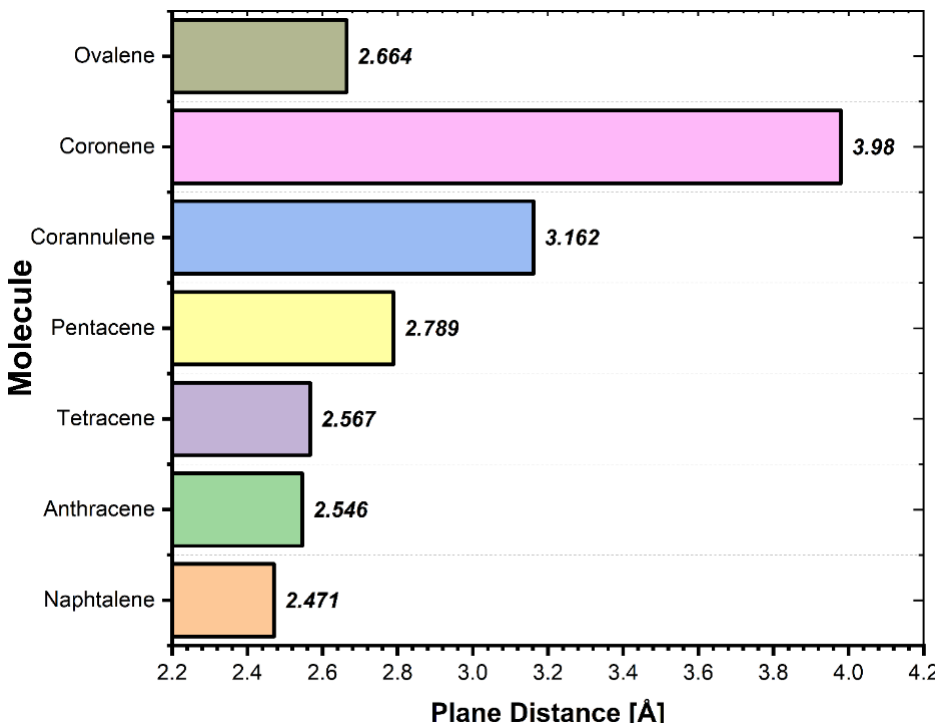
Figure 3. The equilibrium distances between the PAH molecules and the Graphene surface plane. Similarly, the adsorption distance on the graphene surface for other aromatic systems, such as 9,10-anthraquinone (AQ) and phenanthraquinone (PQ) are at 3.19 Å and 3.14 Å, respectively, which correlates well with the presented data [47]. The NCI surface plot and the reduced density gradient (RDG)